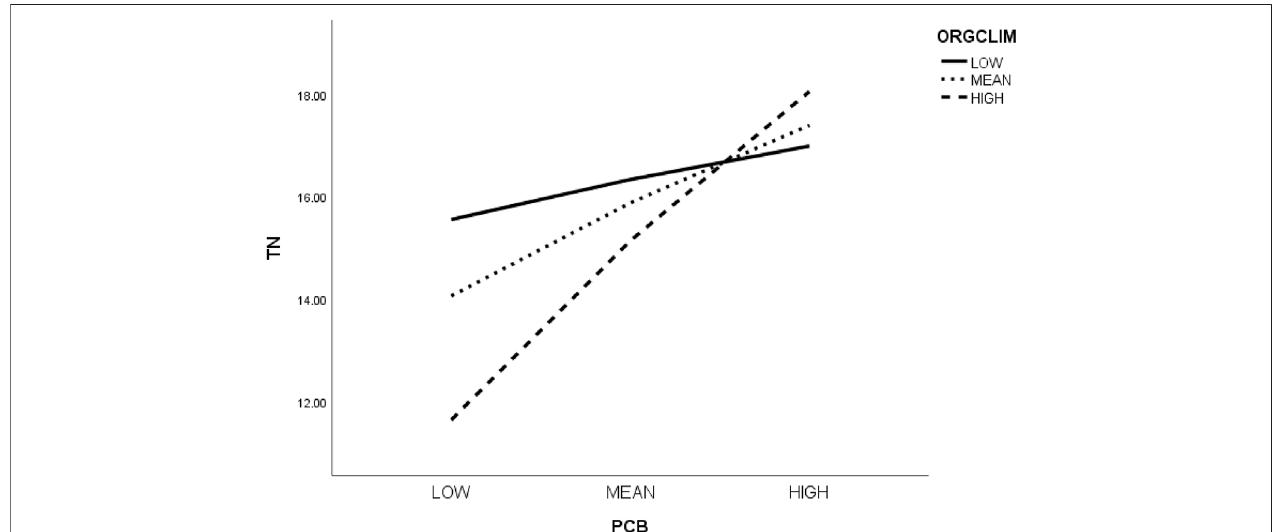
FIGURE 2 | Moderating role of organizational climate in the psychological contract breach and turnover intention relations.